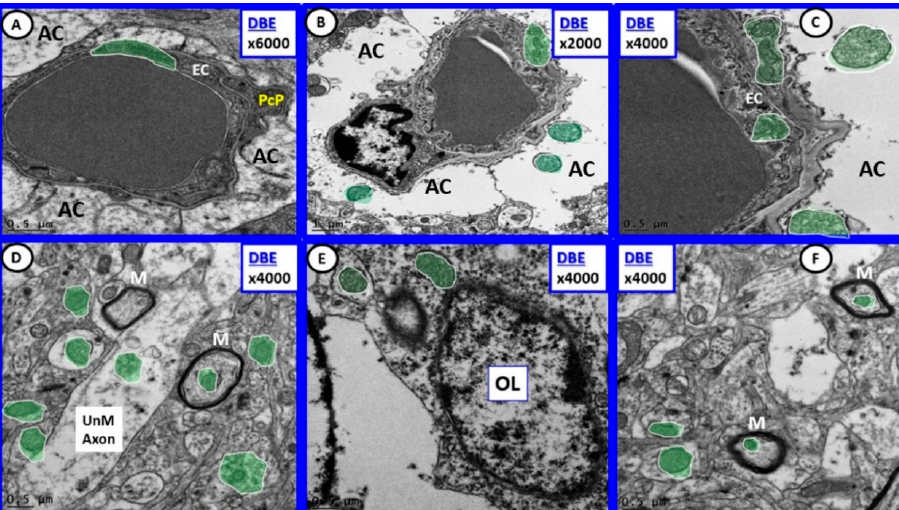
Figure 6. Diabetes-induced aberrant mitochondria remodeling was prevented by empagliflozin. Note that in all panels ( A – F ) the mitochondria are of smaller size and that the mitochondria matrix is electron dense (pseudo-colored green encircled with white lines) in contrast to the swollen aMt with loss of mitochondrial matrix electron density and loss of crista in the previous Figure 5. Magnification 6000× (panel ( A )); 2000× (panel ( B )), and 4000× (panels ( C – F )); Scale bars = 0.5 µm in all images except for panel ( B ) which has a scale bar = 1 µ m. AC = astrocyte; EC = endothelial cell; M = myelin; OL= oligodendrocyte; PcP = pericyte foot process; UnM =